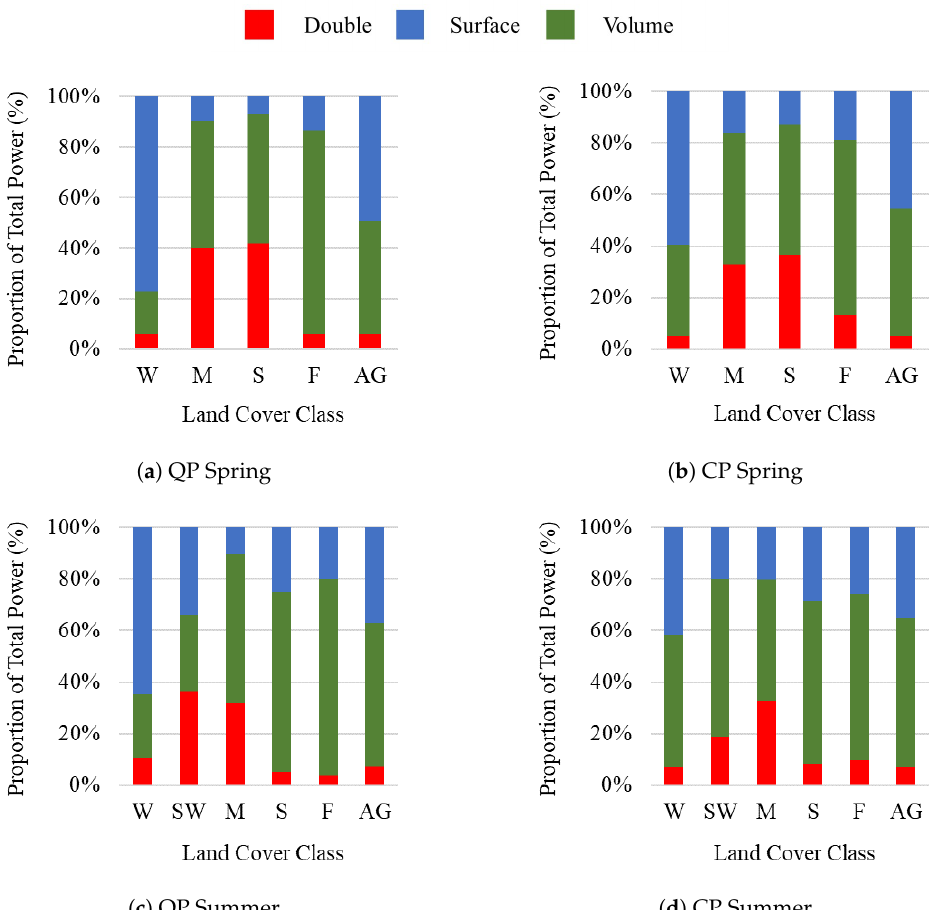
Figure 5. Average (%) contribution to total power attributable to surface (blue), double bounce (red), and volume scattering (green), based on results of the Freeman–Durden decomposition (left) and m -chi decomposition (right) applied to the FQ17W spring (top) and summer (bottom)